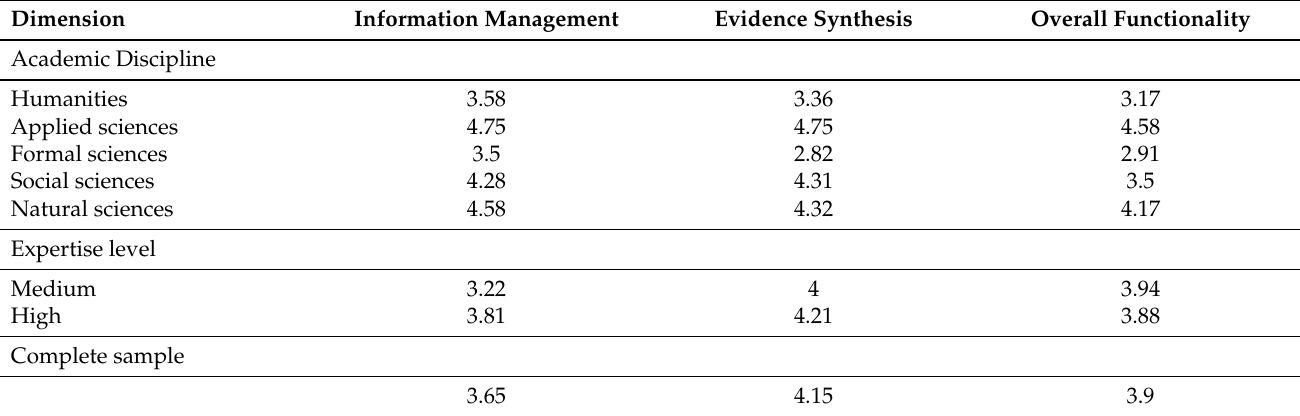
Table 4. Results of the survey by feature